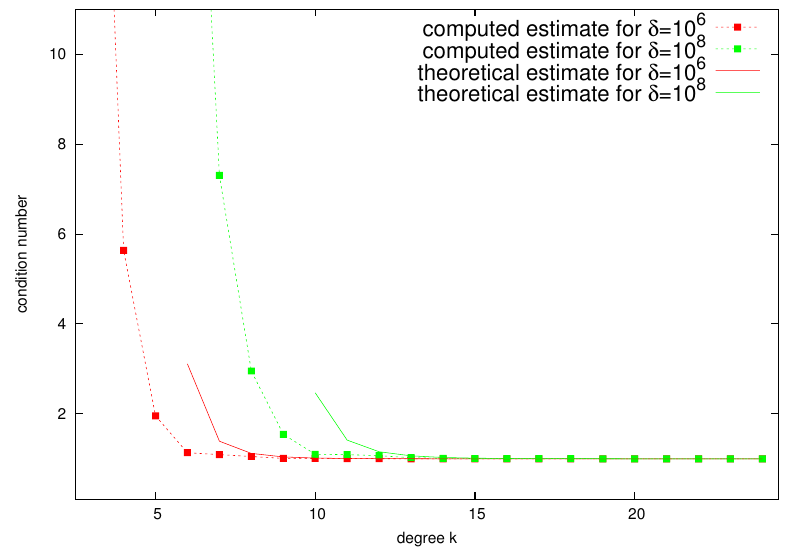
1 0.14 with ] A − − 0.14, k −